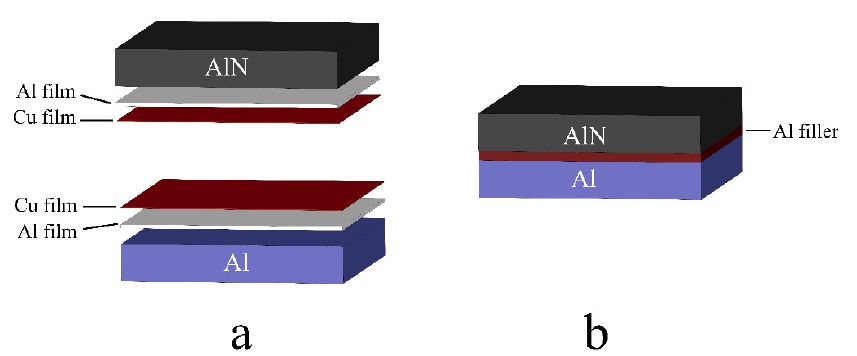
Figure 1. Schematic diagram of AlN/Al brazing. ( a ) Schematic diagram of film deposition; ( b ) Schematic diagram of brazing.